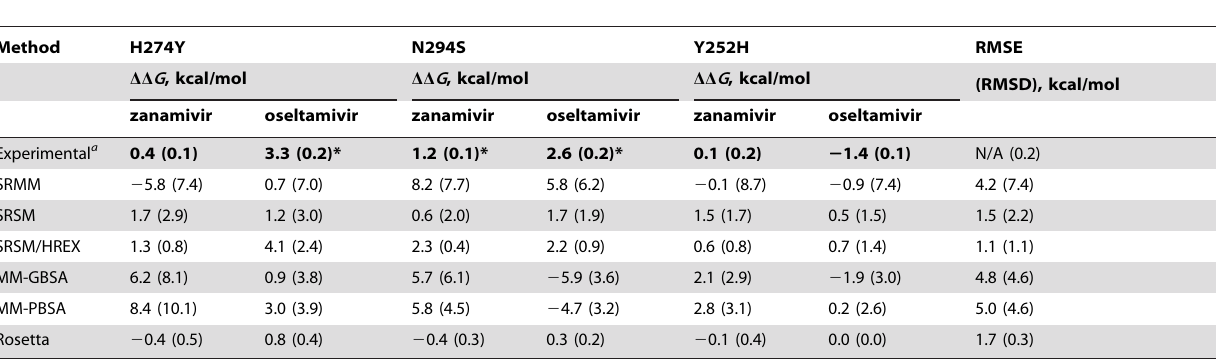
Table 1. Comparison of experimental DD G in oseltamivir and zanamivir for three NA mutations with estimates obtained using different computational